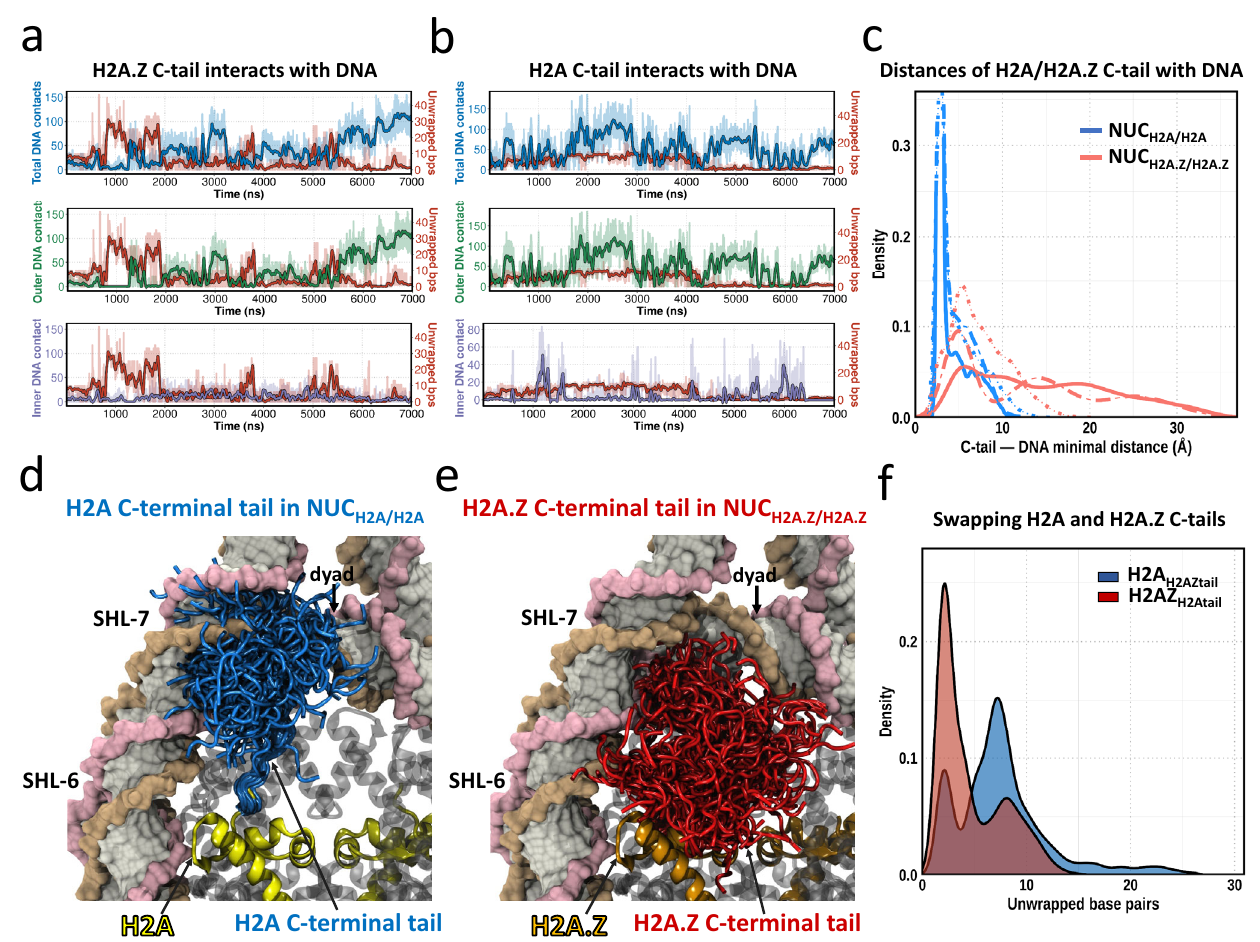
Fig. 2 | H2A.Z C-terminaltailmediatesthe DNAunwrapping.a A representative simulation run shows the coupling between the number of unwrapped base pairs frombothDNAends(red)and thenumber of H2A.Z C-terminaltail — DNAcontacts in NUC H2A.Z/H2A.Z nucleosome. The number of contacts of H2A.Z C-terminal tail with total DNA, outer DNA and inner DNA regions are shown in blue, green and purple,respectively.SeeSupplementaryFig.6forothersimulationruns.Lineswith faded colorscorrespond torawdataandare smoothed withaSavitzky-Golay fi lter using a ten ns window and fi rst-degree polynomial (dark color lines). b Same as a but for NUC H2A/H2A nucleosome. See Supplementary Fig. 7 for other simulation runs. c Distribution ofdistances between H2A (blue) or H2A.Z (red)